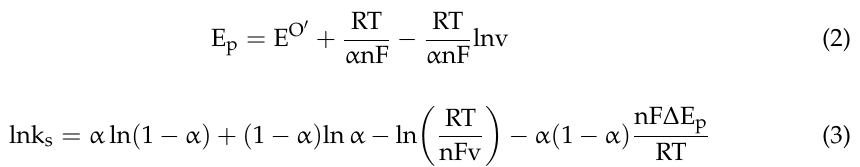
Scheme 1. glucose catalyzed by NADP + -GDH on the biosensor surface. 2.5. Detection of Glucose Concentration in Samples Linear sweep voltammogram (LSV) is a common method for detecting substances. The LSVs of the NF/GDH/IL/mPEG-fMWCNT/GCE are shown in Figure 5A in the pres- ence of different concentrations of glucose (0.8–100 µM). The gradual addition of glucose resulted in a decrease in GDH on the modified GCE, which result in a decrease in peak current as the reaction progressed [41]. The apparent Michaelis–Menten activity ( k (cid:2923)(cid:2911)(cid:2926)(cid:2926) ) indicates the enzyme–substrate kinet- ics of the biosensor: